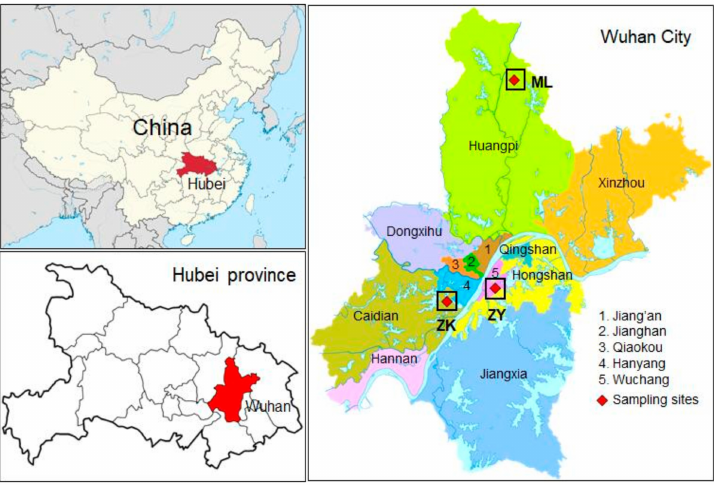
Figure 1. Locations of the sampling sites in Wuhan. ZY: Zi-yang, ZK: Zhuan-kou, ML: Mulan